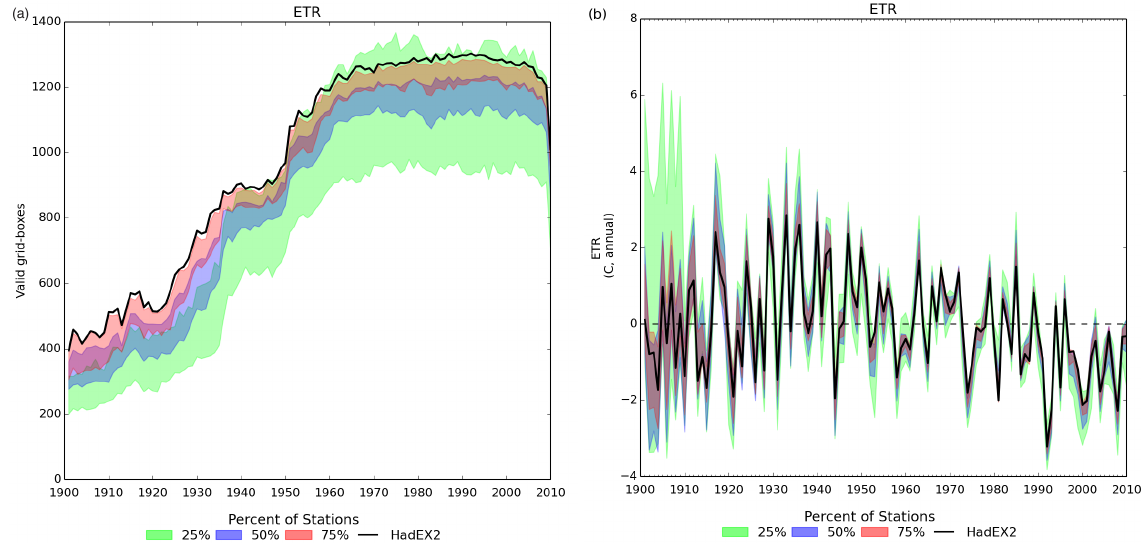
Figure 17. (a) The number of non-missing grid boxes and (b) the time series for the global average of ETR (extreme temperature range) for the sub-sampling runs. Each colour shows the maximum range of the time series for each of the three sets of runs: 25% of stations in green, 50% in blue and 75% in red. These are transparent, so purple is the overlap of the 50 and 75% ranges. The solid black line shows the HadEX2 results in both panels. Note that the global average only takes grid boxes which have 90% completeness or more, whereas all grid boxes are shown in the coverage series. All choices have been centred relative to the climatology period 1961–1990, reducing the spread during this time.